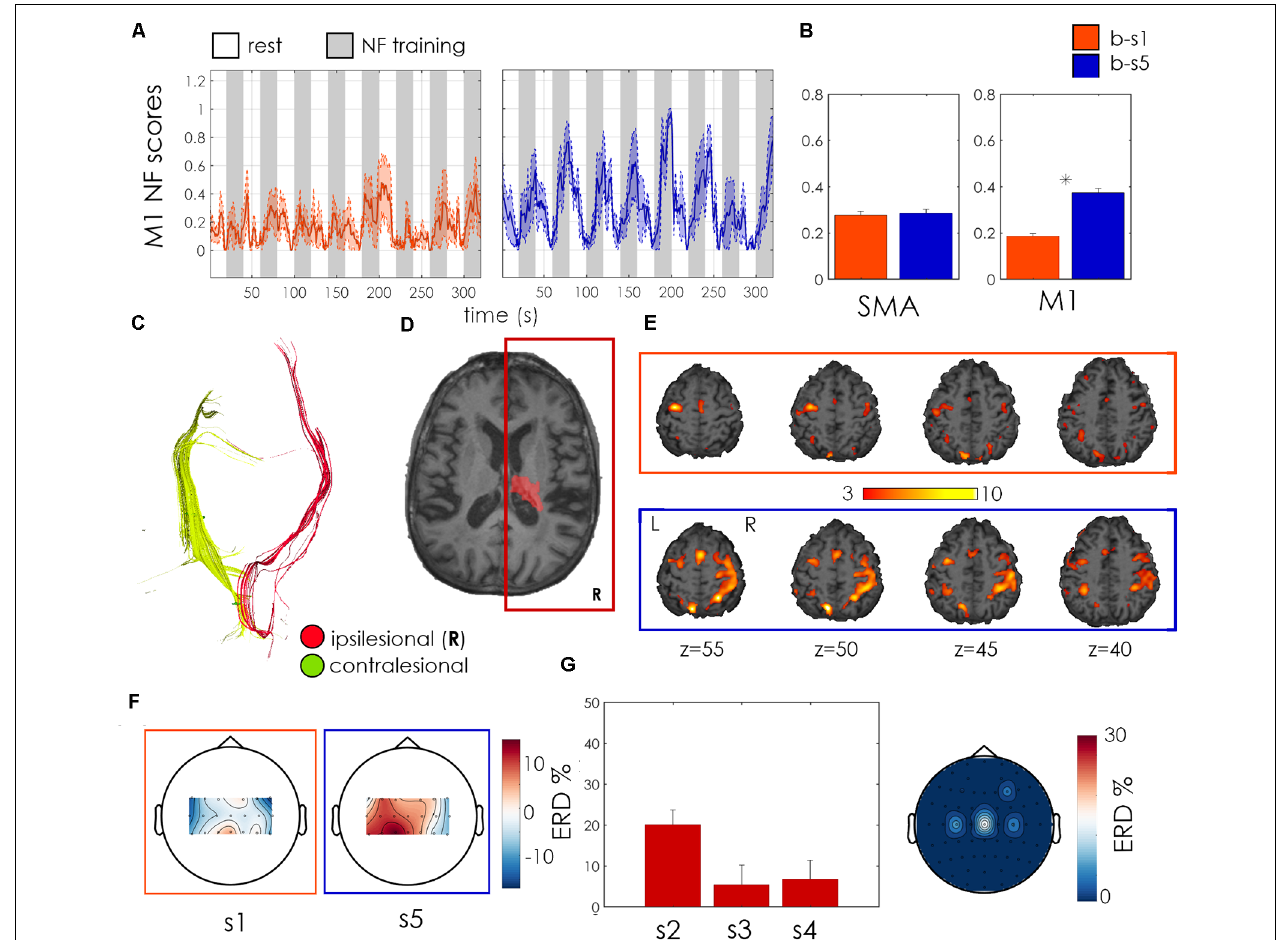
FIGURE 6 | Patient 03 outcome measures. Legend as for Figure 4